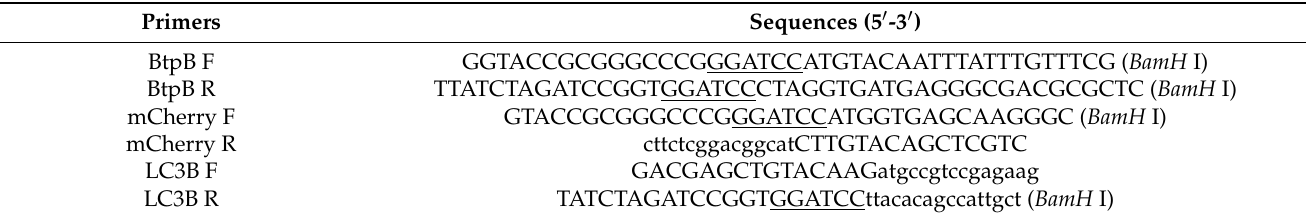
Table 1. Primers used in this